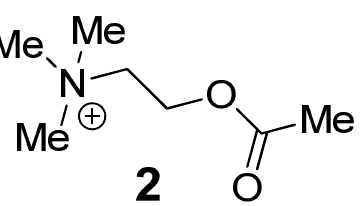
Figure 2. Chemical structure of the neurotransmitter acetylcholine ( 2 ).